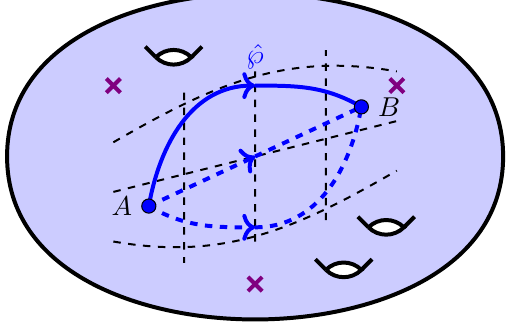
Figure 1 . Paths on parameter space